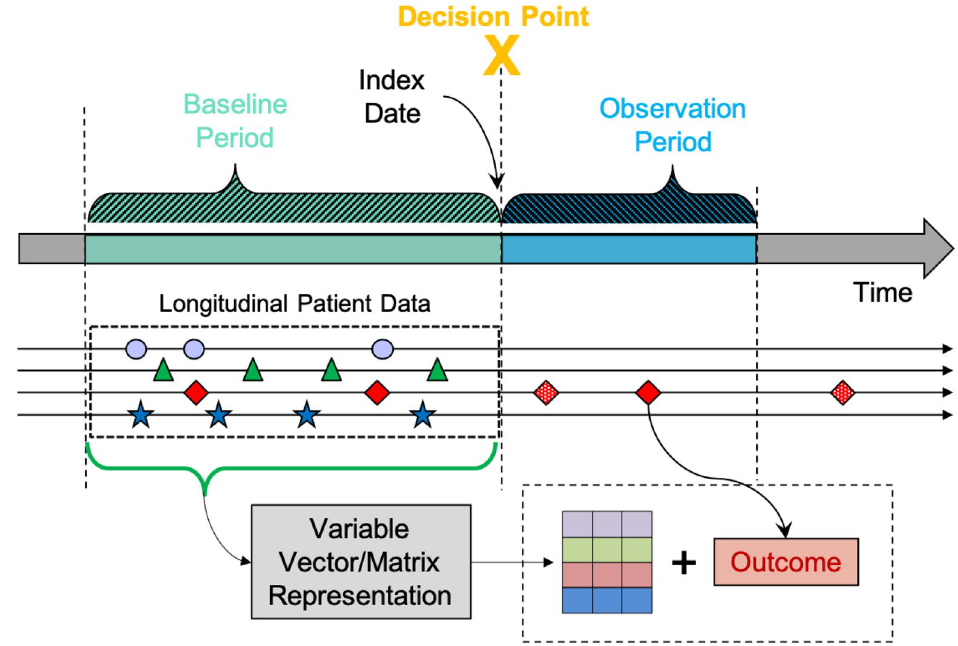
Figure 2. Decision point specification. Each clinical decision point is associated with an index date, a baseline period that precedes the decision point, and an observation period that follows the decision point. Data in the baseline period are processed to extract baseline variables to represent the health condition and active treatment status. Observed treatment decisions are identified at the time of the decision point. Data in the follow-up observation period are analyzed to determine the associated outcome